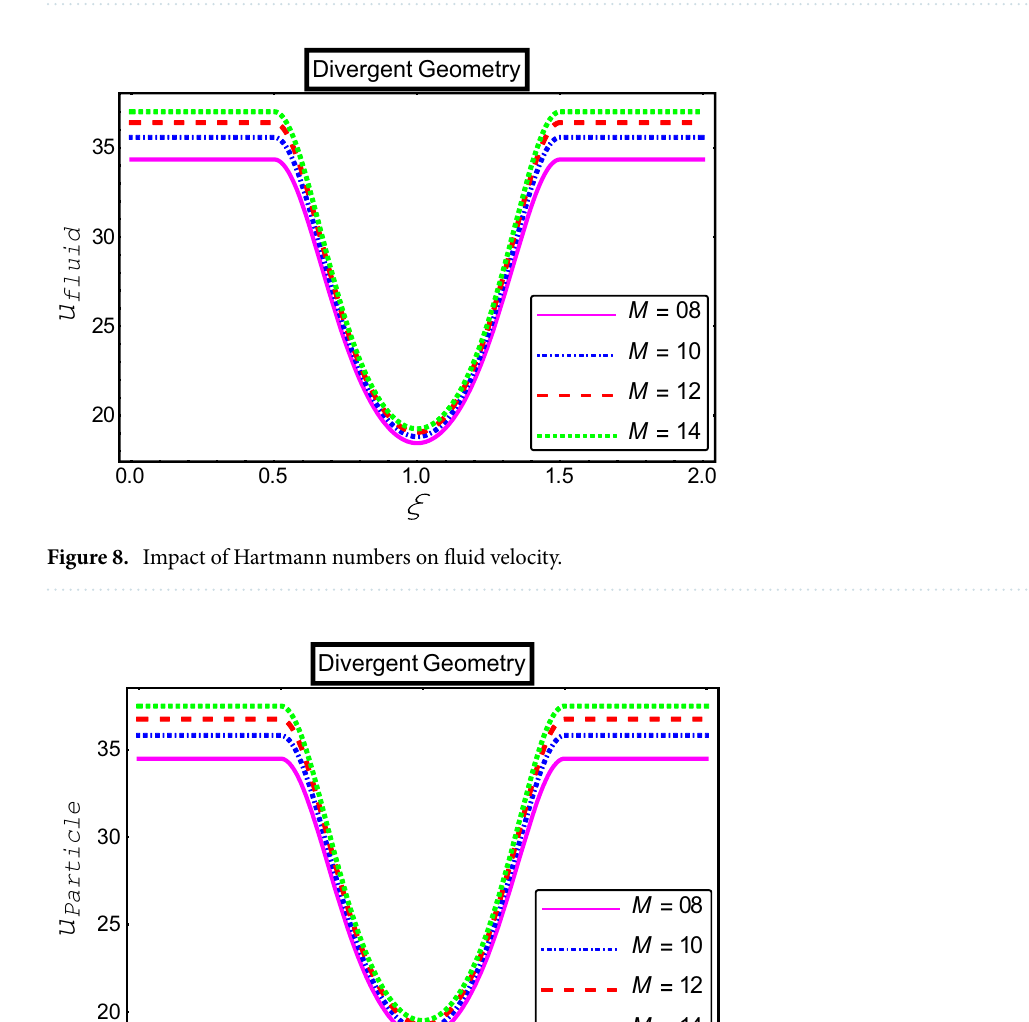
Figure 7. Impact of electro-osmotic parameter on the temperature profile.